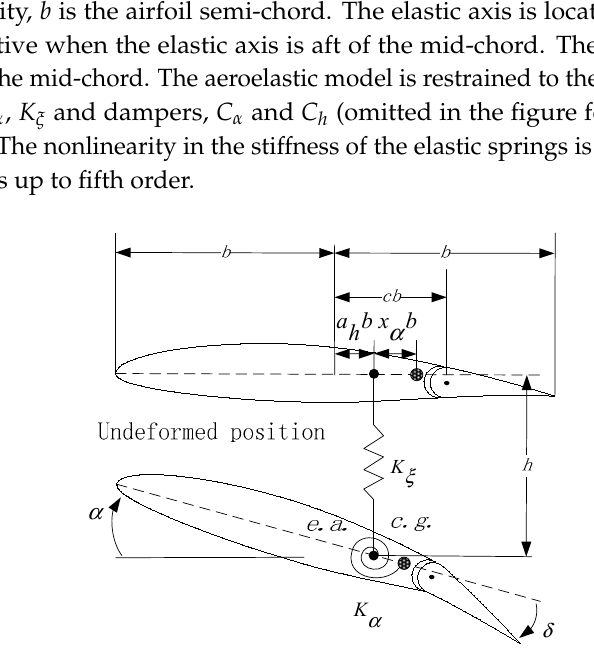
Figure 1. Schematic of an airfoil section with trailing-edge flap; the wind velocity is to the right and horizontal; e . a . and c . g . denote, respectively, the elastic axis and the center of